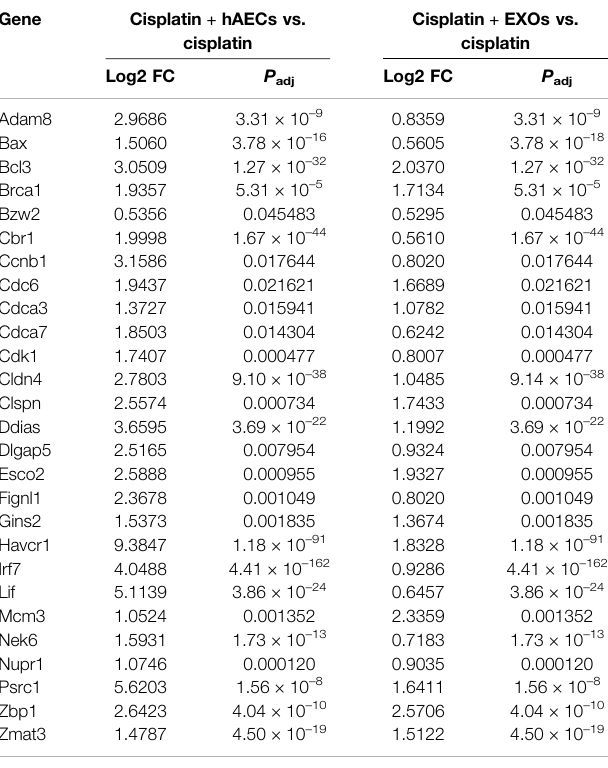
TABLE 1 | Representative DEGs identi fi ed by RNA sequencing in cisplatin + hAECs or cisplatin + EXOs compared with cisplatin-treated tumors. Gene Cisplatin + hAECs vs. Cisplatin + EXOs vs. cisplatin